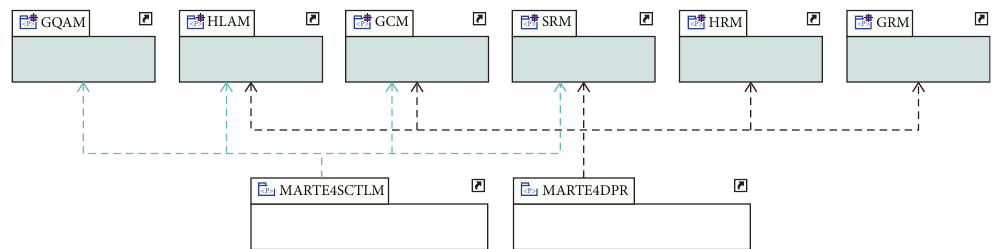
Figure 4: Dependencies of MARTE4DPR and MARTE4SCTLM